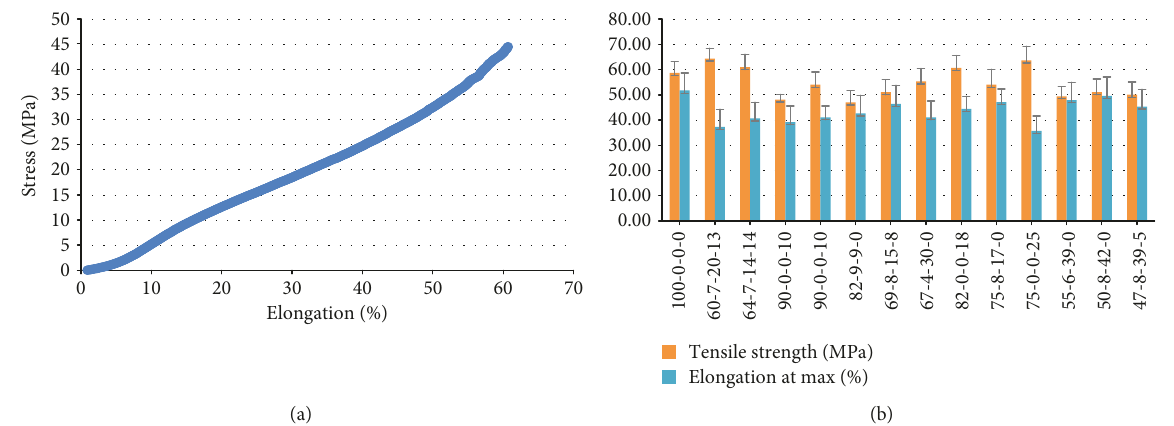
Figure 1: An exemplary stress-elongation at max curve for the sample 60-7-20-13 (a), and the tensile strength and the elongation at max values for the composites